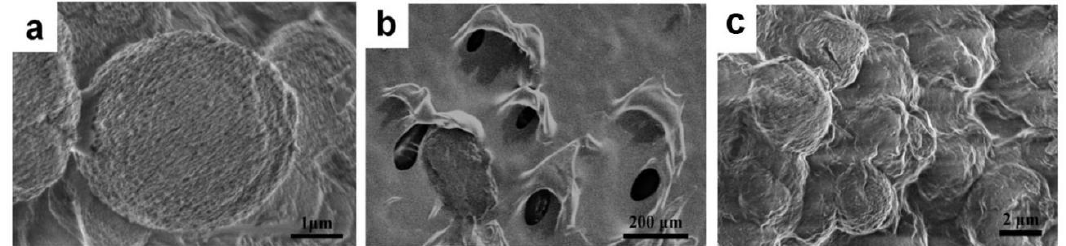
Figure 1. SEM images of ( a ) CaCO 3 and ( b ) chitosan and ( c ) CS – CaCO 3 .